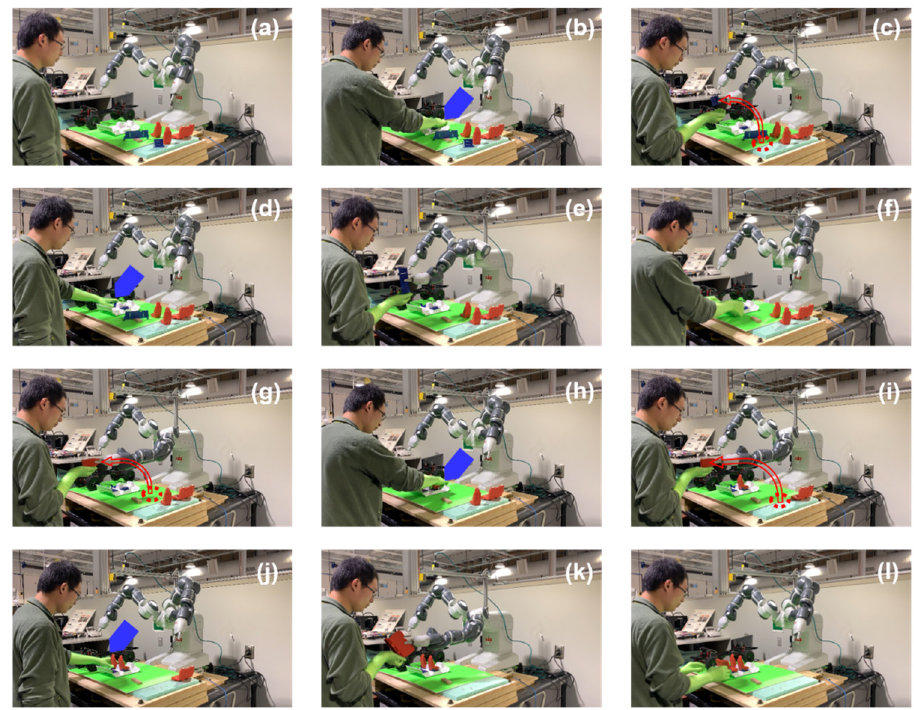
Figure 15. Human-robot collaborative process for a different assembly preference. ( a ) Initial position; ( b ) human worker installs the right seat holder; ( c ) robot delivers the left seat holder to human; ( d ) human worker installs the left seat holder; ( e ) robot delivers the back seat holder to human; ( f ) human worker installs the back seat holder; ( g ) robot delivers right seat to human; ( h ) human worker installs the right seat; ( i ) robot delivers the left seat to human; ( j ) human installs the left seat; ( k ) robot delivers the back seat to human; ( l ) human installs the back seat.